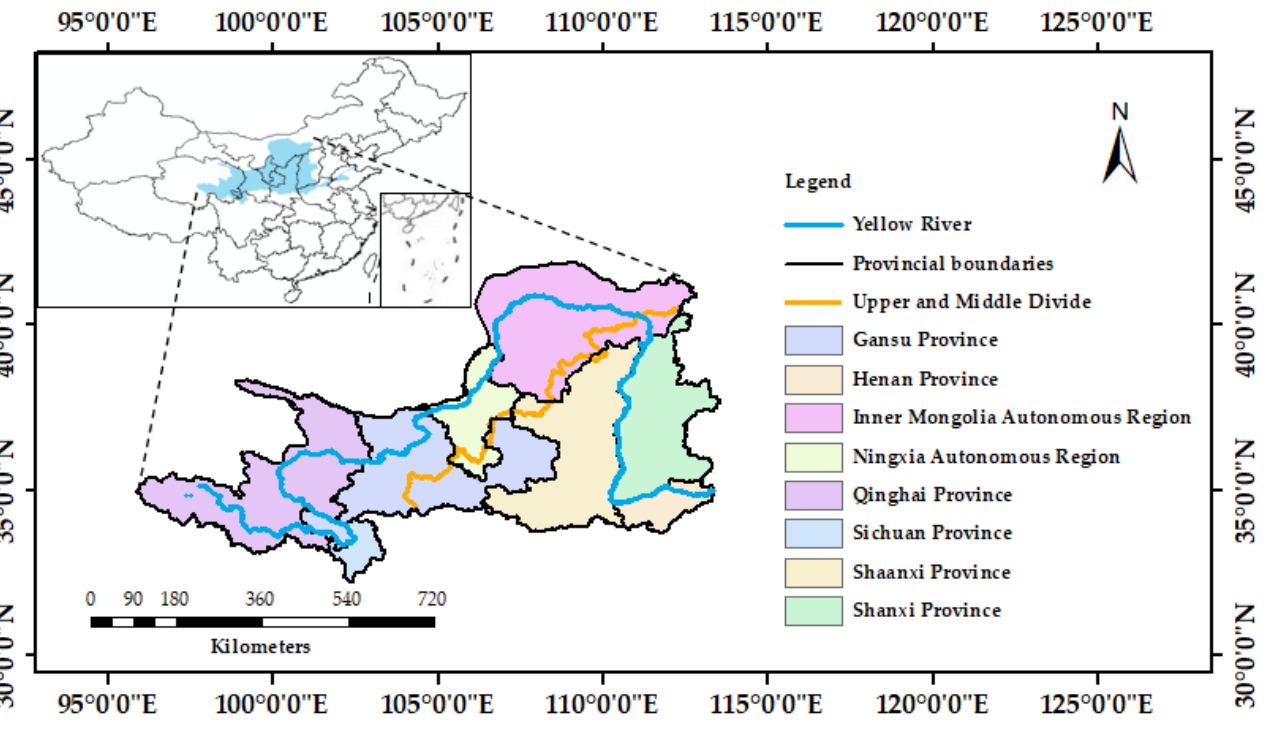
Figure 1. The location of Yellow River